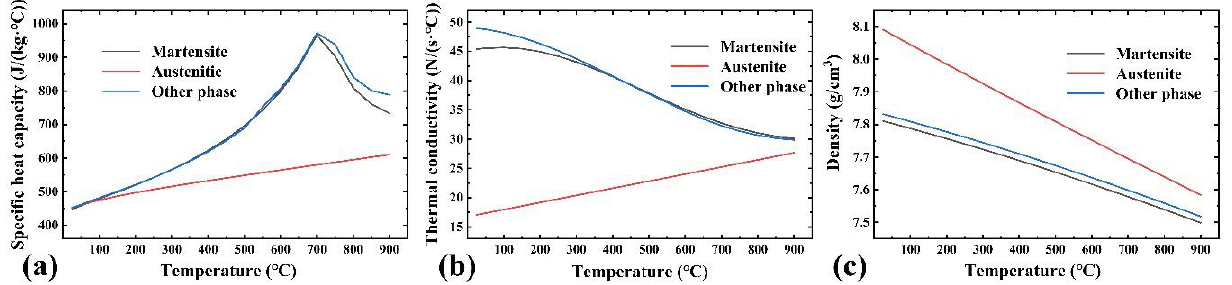
Figure 2. Thermophysical properties of AH36. ( a ) Specific heat capacity; ( b ) Thermal conductivity; ( c ) Density.